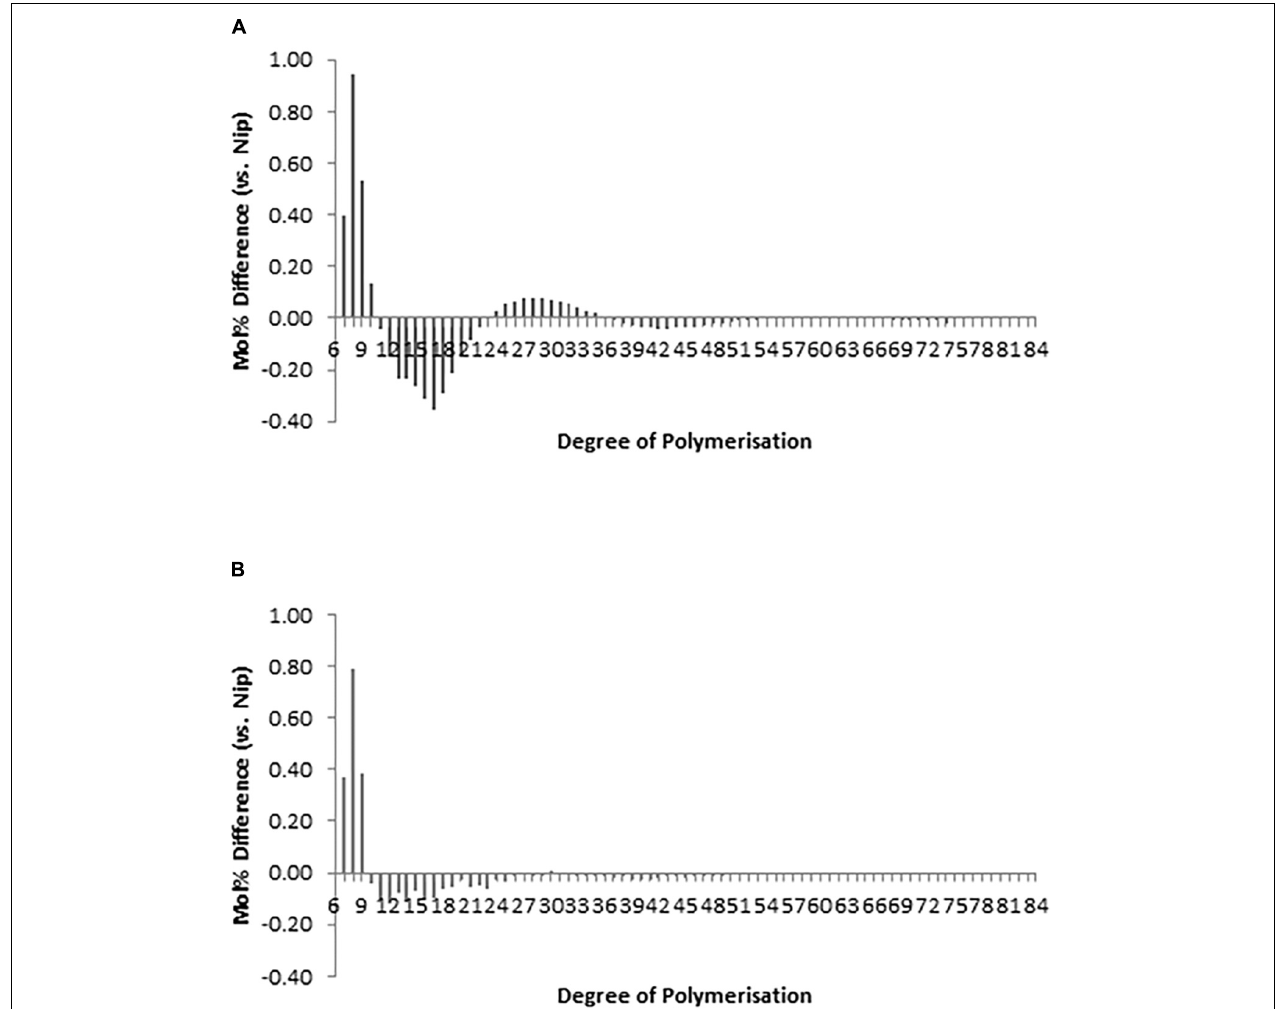
FIGURE 4 | Chain length distribution (CLD) profile of debranched amylopectin from representative (A) hp-SSIIa-op (SS5) and (B) hp-SSIIa-shr (SS28) lines at T1 generation, showing significant elevation in short amylopectin A-chains from DP 6-10 and reduction from DP 12-24 ( P = 0.0004). The results are average of three trials. Comparison of CLD is expressed as a difference plot (percentage of molar molecules) between each mutant and control